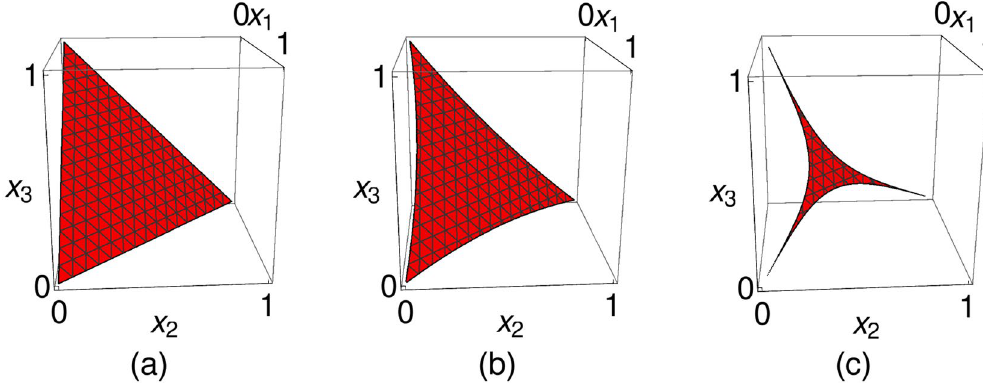
Figure 1. Inner region: set of parameters ( x 1 , x 2 , x 3 ) with all three γ k ( t ) > 0 for some time t. ( a ) t = 0 (defining triangle), ( b ) some later time t > 0, ( c ) t → ∞ (asymptotic